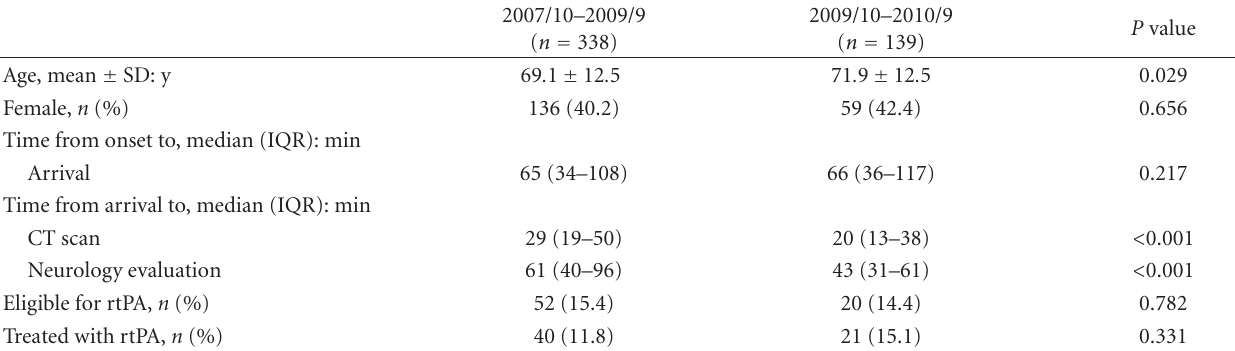
Table 1: Patients with acute ischemic stroke directly presenting to the emergency department within 3 hours of stroke onset.